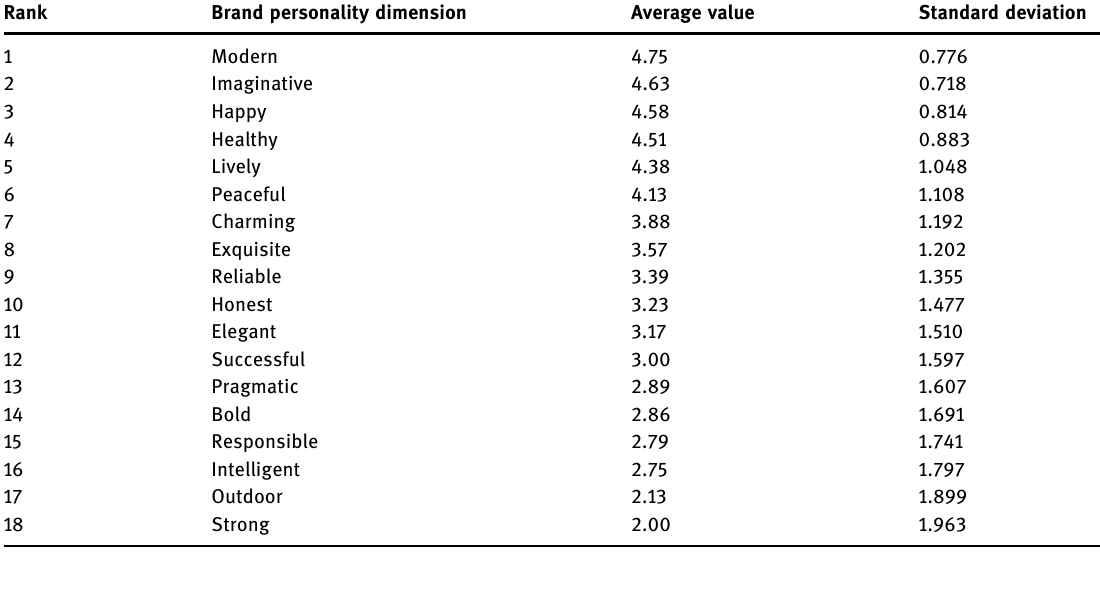
Table 2: Descriptive statistical results of brand personality